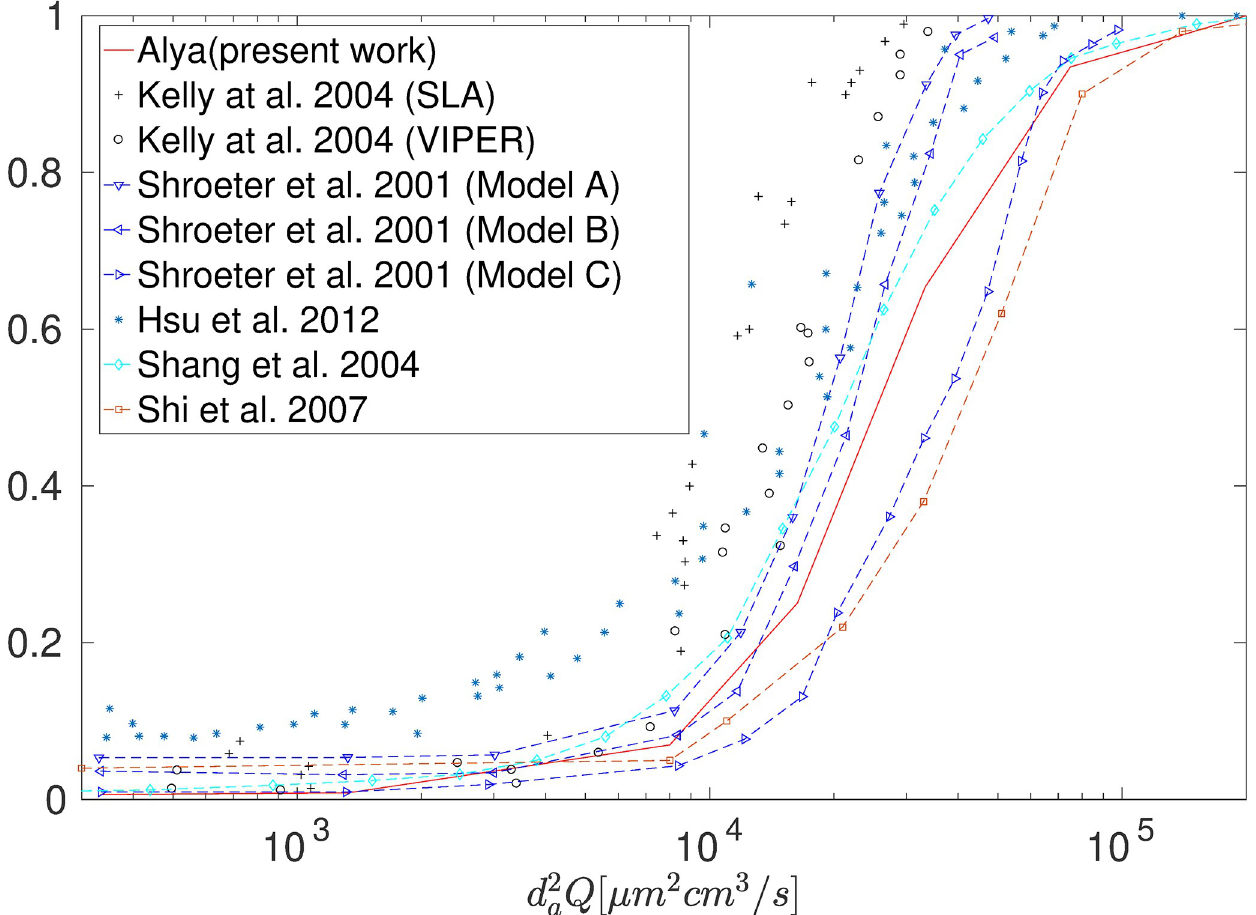
Fig 8. Micro particle deposition efficiency comparison between simulation and